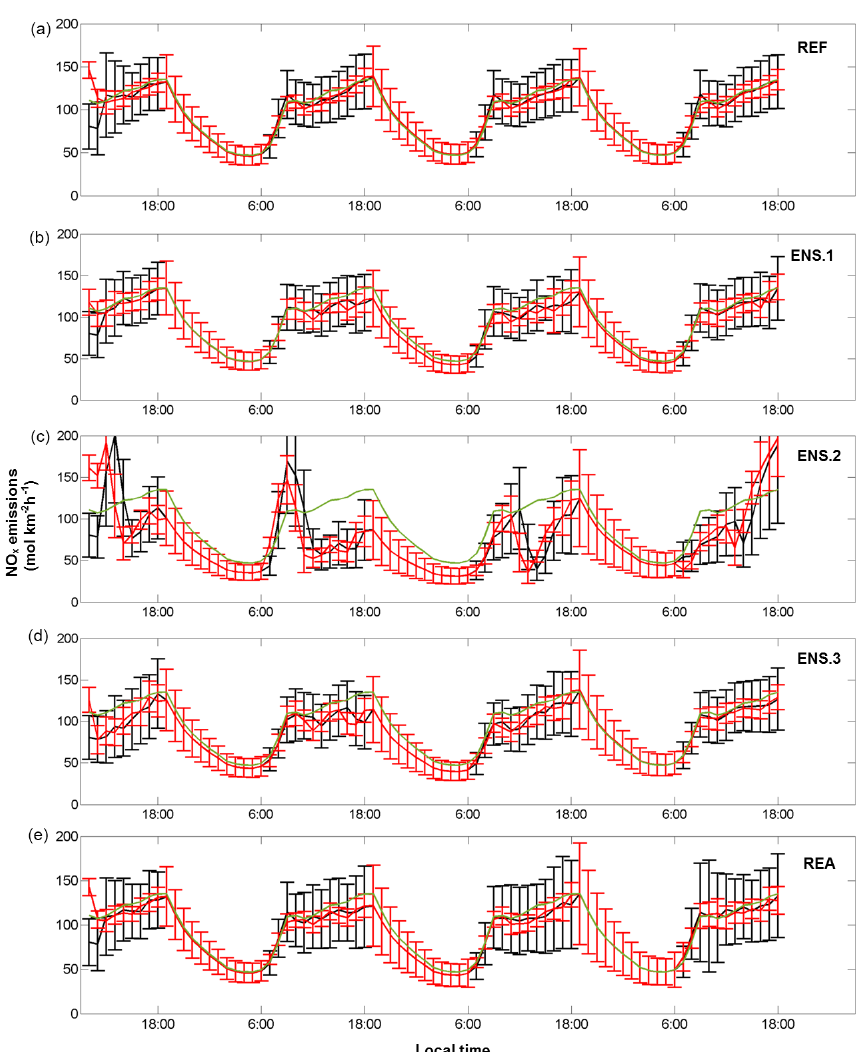
Figure 5. Time evolution of averaged Denver prior (black), posterior (red), and true (green) emissions for REF, ENS.1, ENS.2, ENS.3, and REA (from a to e ).The error bar is defined by the ensemble spread and represents the uncertainty of the prior and posterior